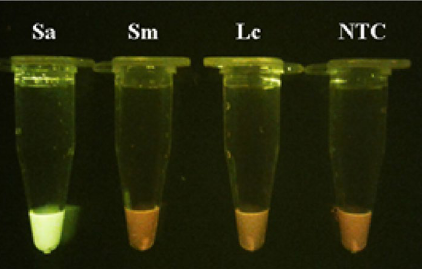
Figure 6. Specificity of LAMP primers to detect S. aureus . A LAMP reaction was developed against other species bacteria to evaluate their specificity against S. aureus (Sa). In both bacteria tested there is no green fluorescence indicating that there is no cross reaction with Serratia marcescens ( Sm ) and Lactobacillus casei ( Lc ); which show a coloration like the non-template tube